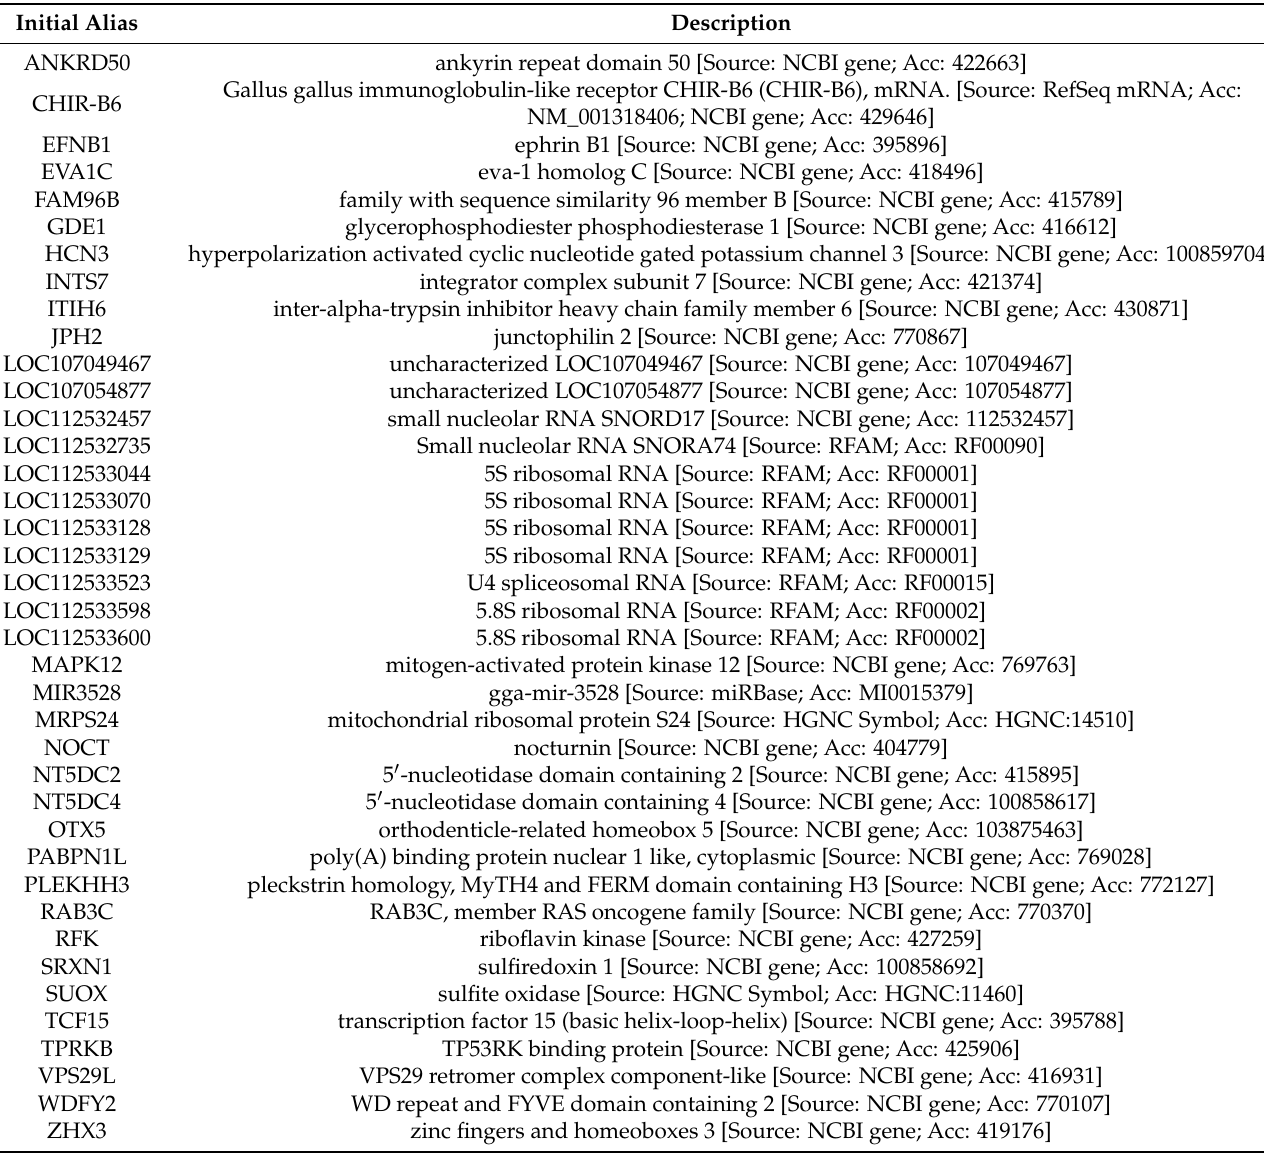
Table 2. Annotated differentially upregulated genes in Lohmann Dual (LD)